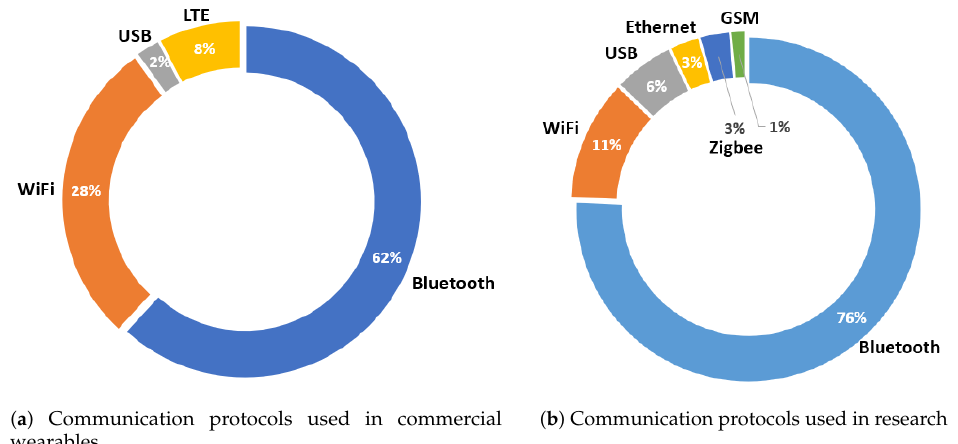
Figure 13. Distribution of the communication protocols integrated into the marketed devices ( a ) and those developed in the literature ( b ).